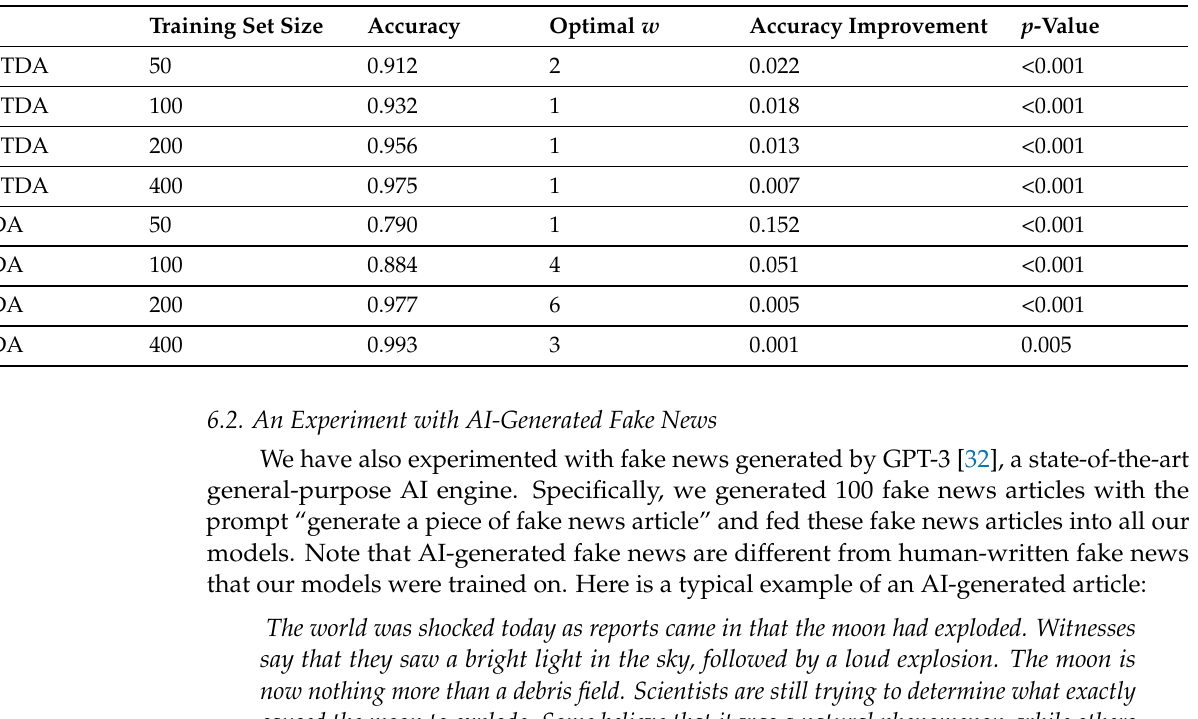
Table 4. Accuracy table of all ensembles of a deep learning model with TDA. Every time, we report the average accuracy of models trained on 50 randomly chosen training sets, the optimal value of w (weight of the deep learning model in the ensemble), improvement in average accuracy achieved by ensembling the deep learning model with TDA, and the p -value of the t -test to test the hypothesis that the ensemble has a higher test accuracy than the pure deep learning